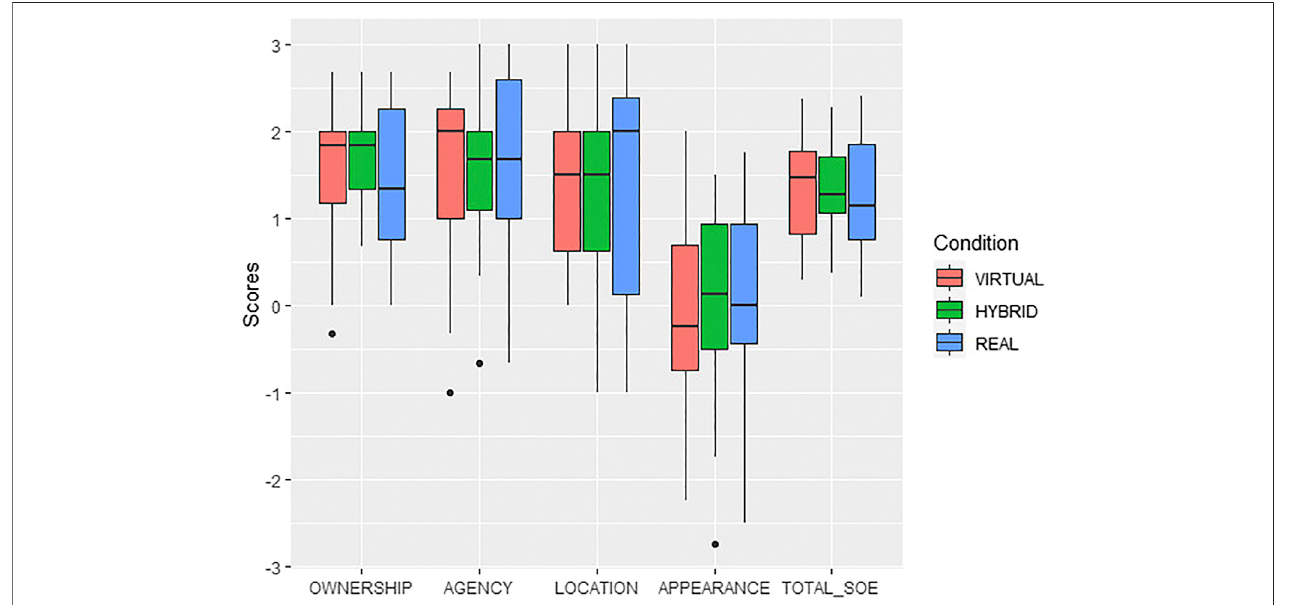
FIGURE 5 | Boxplots representing the averaged embodiment scores for each condition. The scores all range from − 3 to + 3.